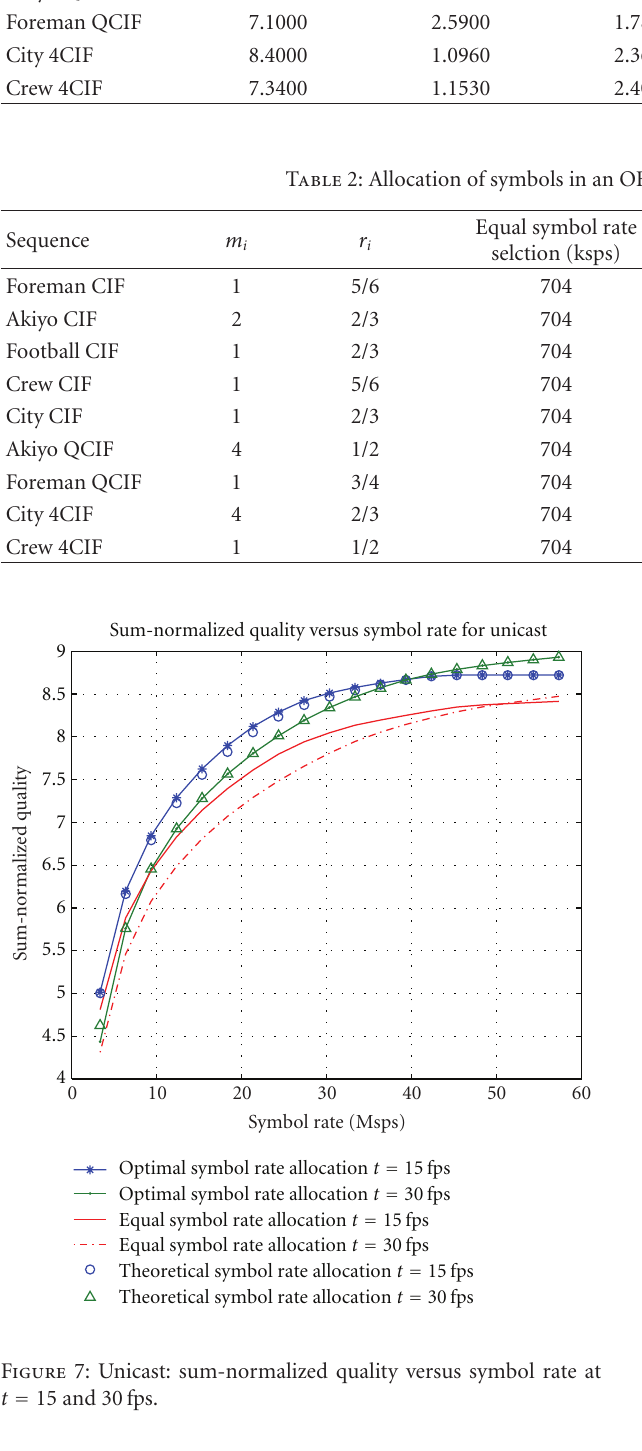
Figure 7: Unicast: sum-normalized quality versus symbol rate at t = 15 and 30fps.